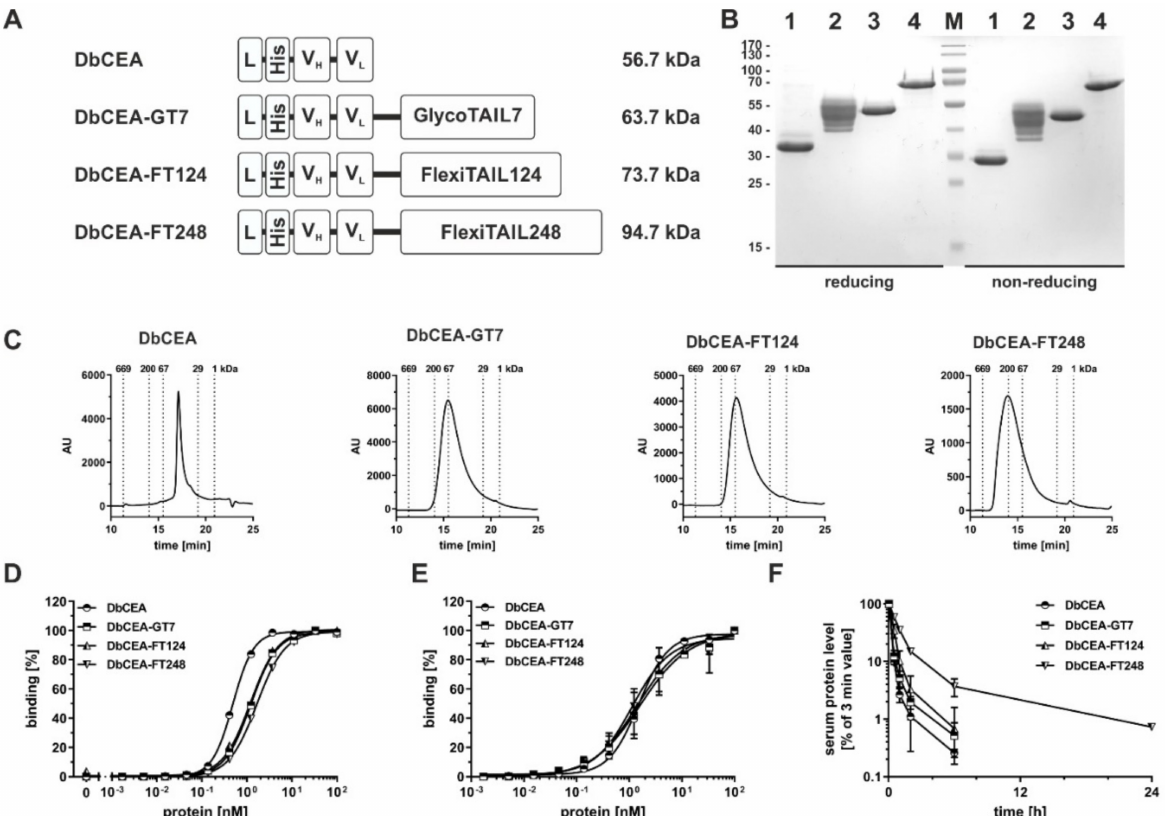
Figure 3. Analysis of DbCEA-based antibody molecules. ( A ) Schematic illustration of the bivalent DbCEA molecules comprising C-terminal GlycoTAIL or a FlexiTAIL moiety and/or N-terminal a His-tag. ( B ) SDS-PAGE analysis of the purified DbCEA molecules (1: DbCEA, 2: DbCEA-GT7, 3: DbCEA-FT124, 4: DbCEA-FT248) under reducing and non-reducing conditions in a 12% ( m / v ) acrylamide gel (3 µ g were loaded per lane; M: marker). ( C ) Size-exclusion chromatography of purified DbCEA molecules. ( D ) Binding of different bivalent DbCEA molecules to immobilized CEA in ELISA. ( E ) Cell binding of the different DbCEA molecules to the colon cancer cell line LS147T determined by flow cytometry. Bound antibodies were measured using a PE-conjugated anti-His antibody. ( F ) Pharmacokinetic analysis of different DbCEA molecules, which were applied intravenously into immunocompetent CD1 mice. Protein amount of blood samples was determined via ELISA experiments. We calculated for the terminal half-life as well as for the drug exposure of the DbCEA-FT248 very strong significant differences compared to all other molecules (****). Mean ± SD, n =